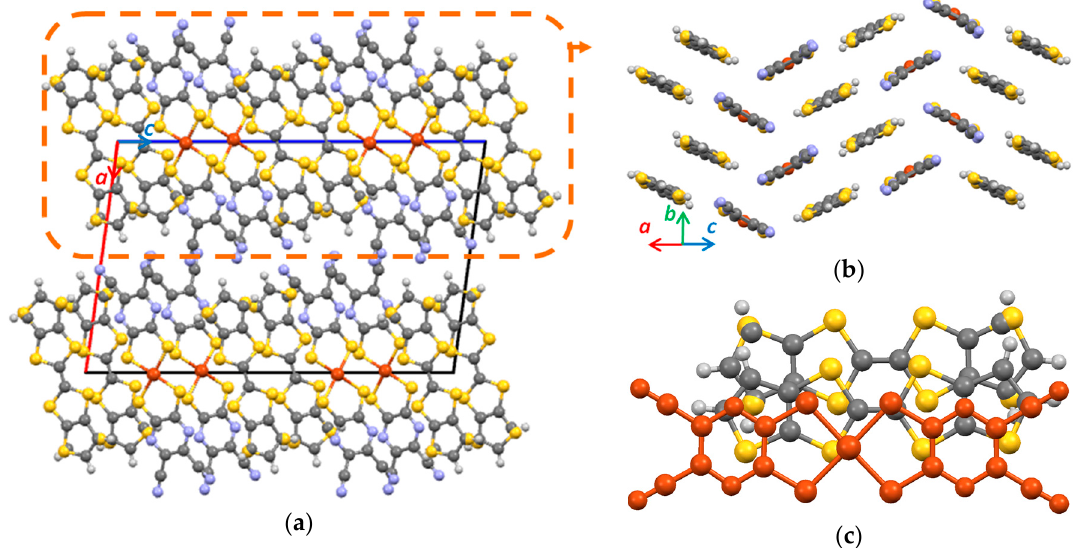
Figure 4. Crystal structure of ( α -DT-TTF)[Cu(dcdmp) 2 ] ( 3 ): ( a ) view along the stacking axis; ( b ) partial view along the long axis of the molecules of neighbouring chains in the same layer; and ( c ) overlap mode between chains in the same layer.